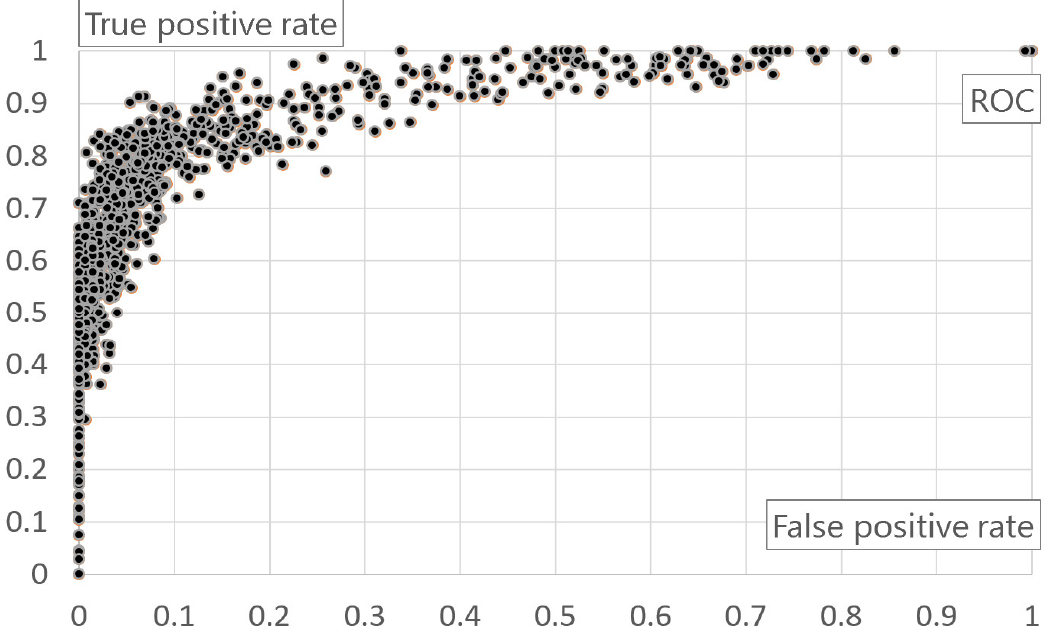
Figure 11. Result of ROC of deep neural networks.